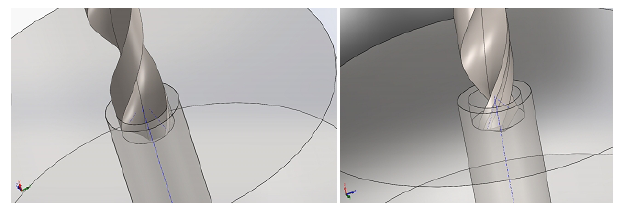
Figure 29. SolidWorks assembly of the drill bit and